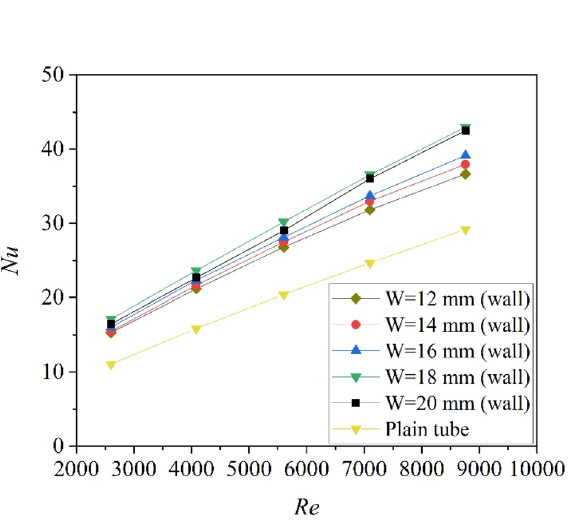
Figure 7. Nusselt numbers of tube with center-placed twisted tape inserts at different tape width.